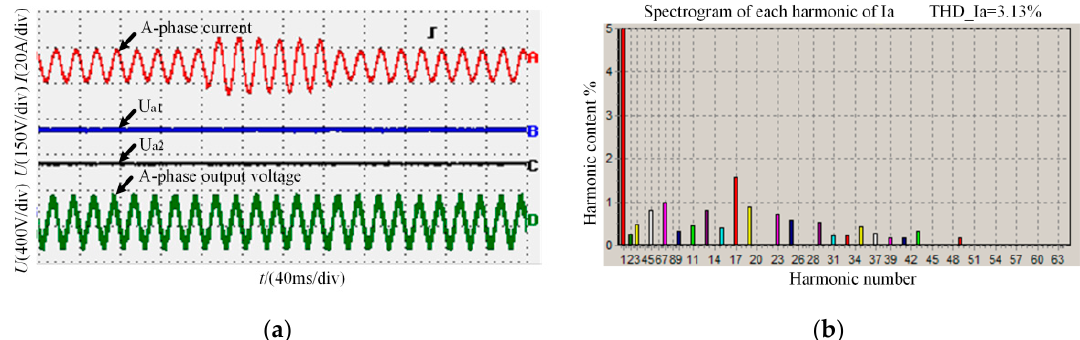
Figure 19. After compensation: ( a ) Grid current, two capacitor voltages, and the output voltage of the